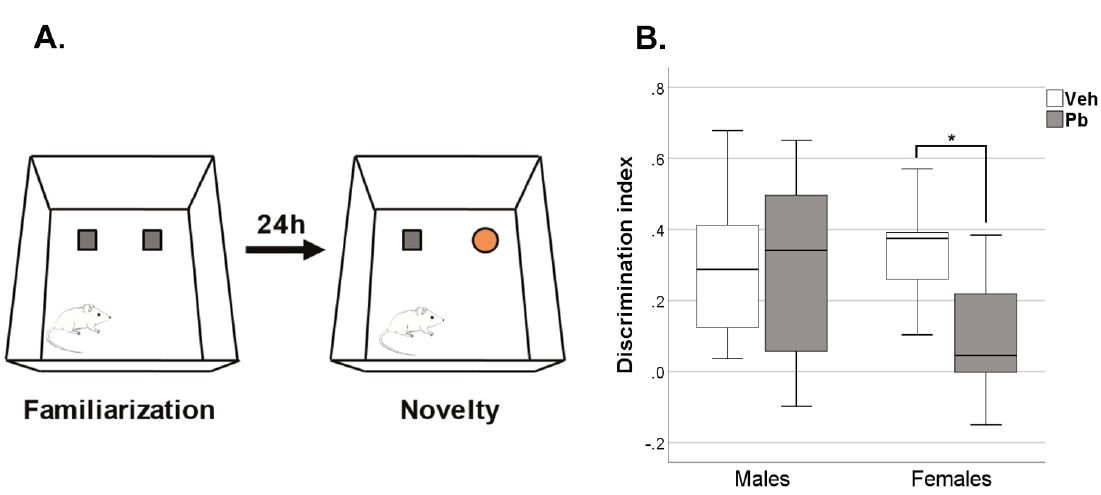
Figure 5. Effects of Developmental Pb Exposure on Long-Term Recognition Memory Assessed in Novel Object Recognition (NOR). ( A ) Schematic representation of the NOR task, consisting of Familiarization phase with two identical objects (represented as squares) and Novelty phase in which one of the two familiar objects (represented as a square) was replaced by a novel object (represented as a circle); ( B ) Discrimination index between a familiar object and novel one during Novelty session. n = 16 (7 females and 9 males)/group; * p < 0.05.